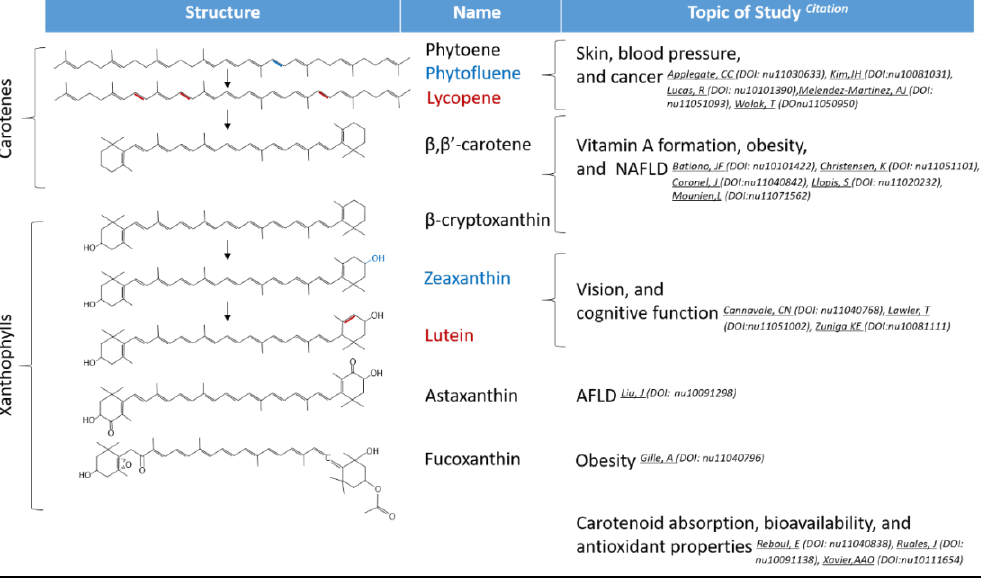
Figure 1. Topics covered by the Special Issue on carotenoids and human health. Colors present on carotenoids denote structural changes between similar carotenoids. Digital object identifier (DOI), non-alcoholic fatty liver disease (NAFLD), and alcoholic fatty liver disease (AFLD).